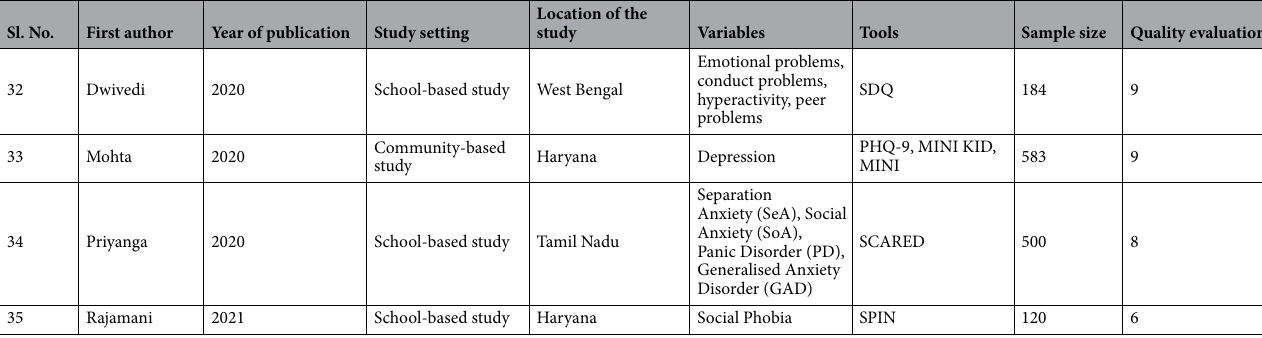
Table 1. Study characteristics (n = 35). GSHS -Global School-based Student Health Survey, SCARED - Screen for Child Anxiety Related Emotional Disorders, K-SADS-PL -Schedule for Affective Disorders and Schizophrenia for School-Age Children/Present and Life-time Version, BDI -Beck Depression Inventory, DASS- 21 -Depression Anxiety and Stress Scale-21, SPIN -Social Phobia Inventory, SDQ -Strengths and Difficulties Questionnaire, PHQ-A -Patient Health Questionnaire-9 modified for Adolescents, MHS-CONNERS-3 -Multi Health Systems (MHS)- CONNERS-3, HADS -The Hospital Anxiety and Depression Scale, MINI KID -Mini International Neuropsychiatric Interview for children/adolescent, TSQ -Teenage Screening Questionnaire- Trivandrum, KADS -Adolescent Depression Scale, PHQ-9 -Patient Health Questionnaire, BPC -Brief Problem Checklist, CDI -Children’s Depression Inventory, RCMAS -Revised Children’s Manifest Anxiety Scale, MINI - Mini International Neuropsychiatric Interview, IPAQ -International Physical Activity Questionnaire, AD - Anxiety Disorders, PD -Panic Disorders, SoA -Social Anxiety, SeA -Separation Anxiety, GAD -General Anxiety Disorder, DD -Depressive Disorder, ADHD -Attention Deficit Hyperactivity Disorder, MDD -Major Depressive